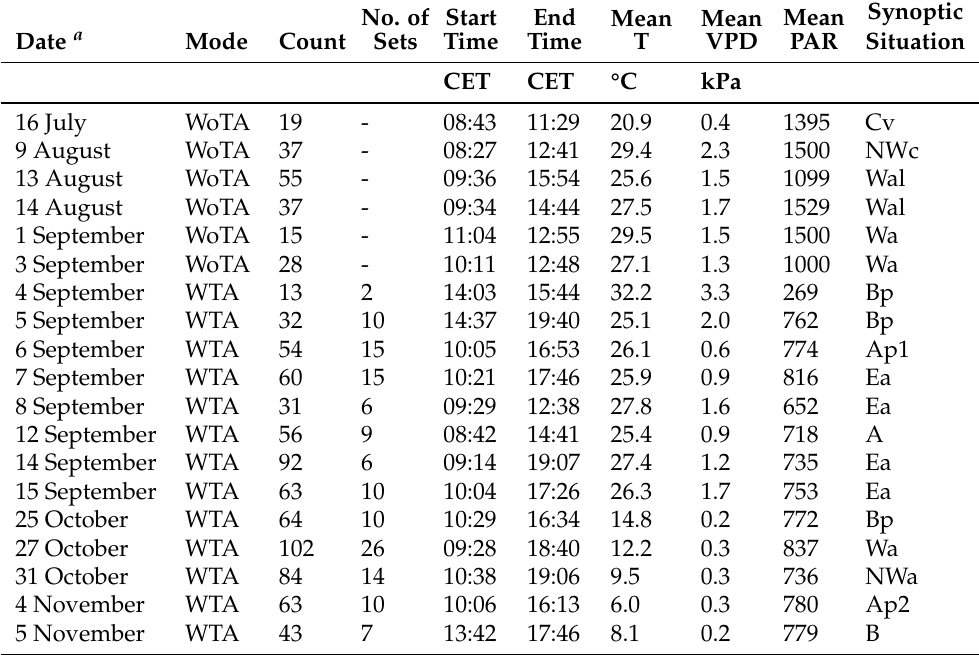
Count represents the overall number of individual measurements, CET is an abbreviation for Central Euro- pean Time, T represents temperature in the chamber, VPD represents vapor pressure deficit in the